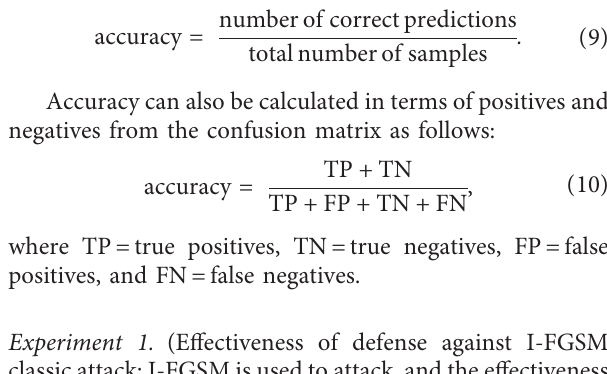
Figure 5: Defense